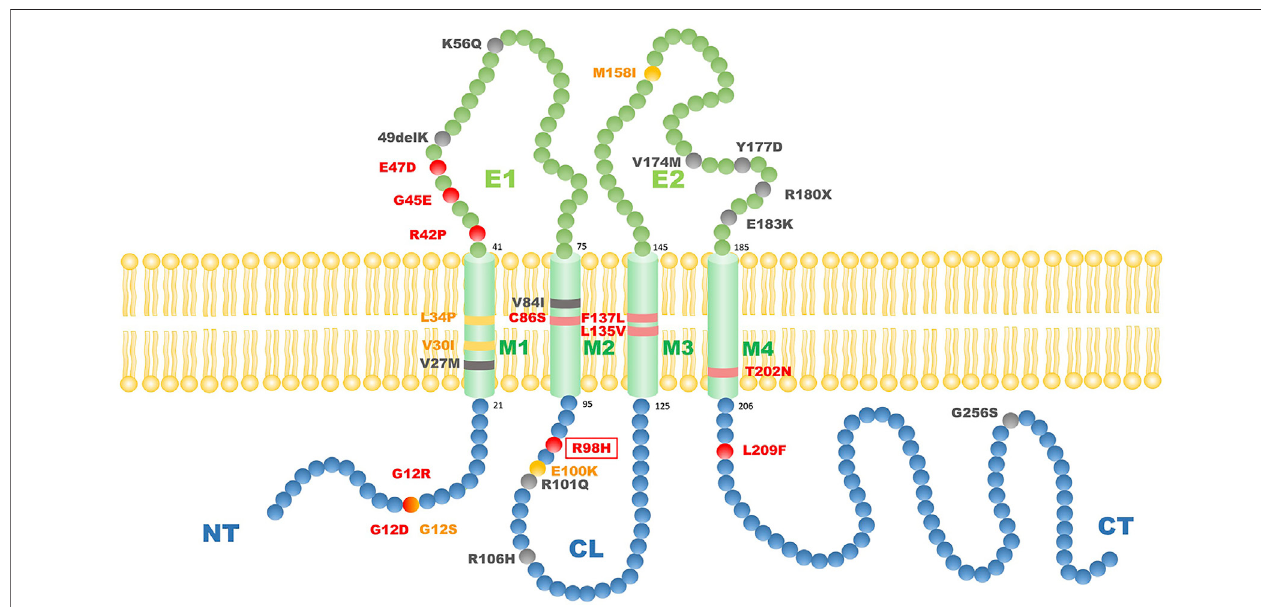
FIGURE4| Thescheme ofreportedGJB3 mutation related toEKVand autosomal dominant GJB3 point mutations related toNSHL. Redballsindicate autosomal dominantmutationswithEKVphenotypes;yellowballsindicateautosomalrecessivemutationswithEKVphenotypes;blackballsindicatecommonautosomaldominant GKB3 mutation related to NSHL. The red frameindicates the mutation wereport in this case. M1 – M4 refers to transmembranedomains. E1and E2referto extracellular domains. CL refers to cytoplasmic loop. NT refers to cytoplasmic amino terminus. CT refers to cytoplasmic carboxy terminus.